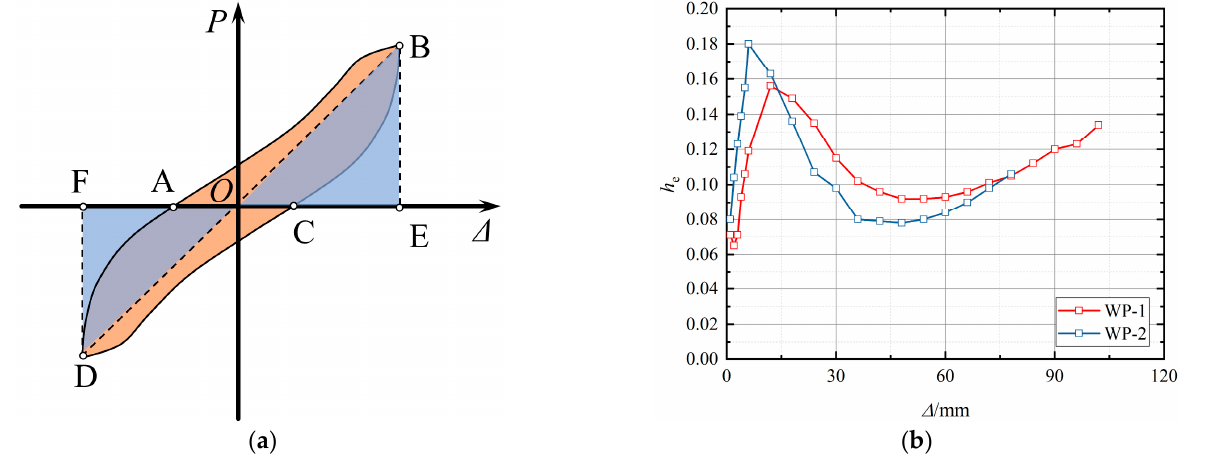
Figure 15. Energy dissipation capacity: ( a ) schematic of the hysteresis loop; ( b ) the equivalent viscous damping coefficient of the specimen.